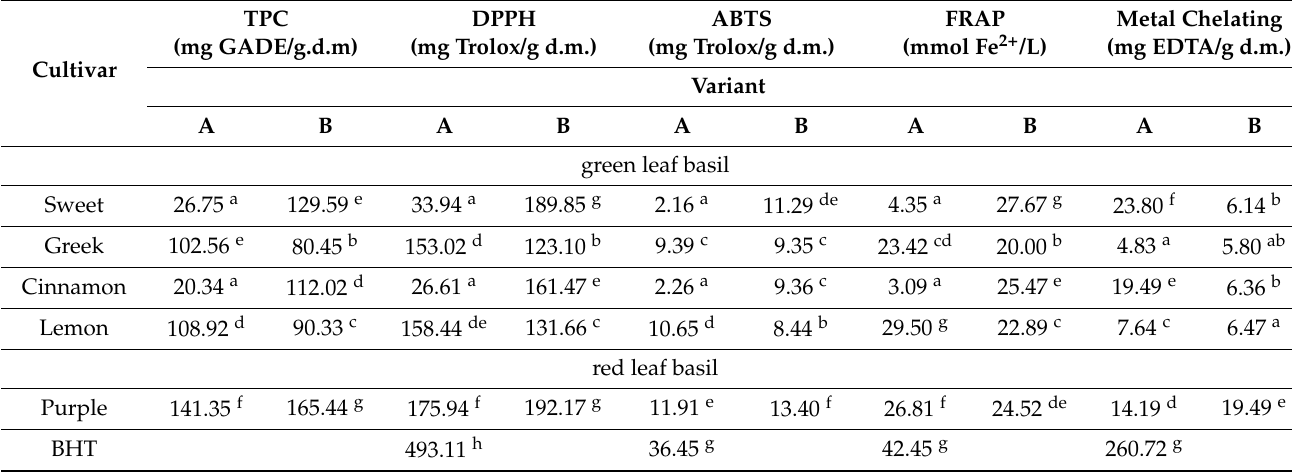
Table 1. Total phenolic content (TPC) and total capacity for extracts of basil cultivars determined using DPPH, ABTS, and FRAP tests and metal chelating